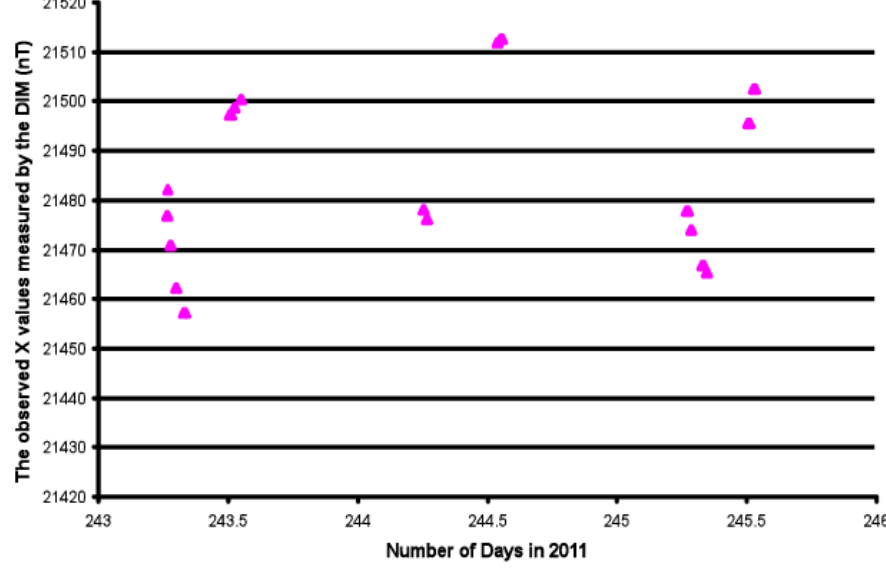
Figure 3. The absolute values of the X magnetic field observed on the absolute pillar of Tihany observatory in the test period of the DIDD